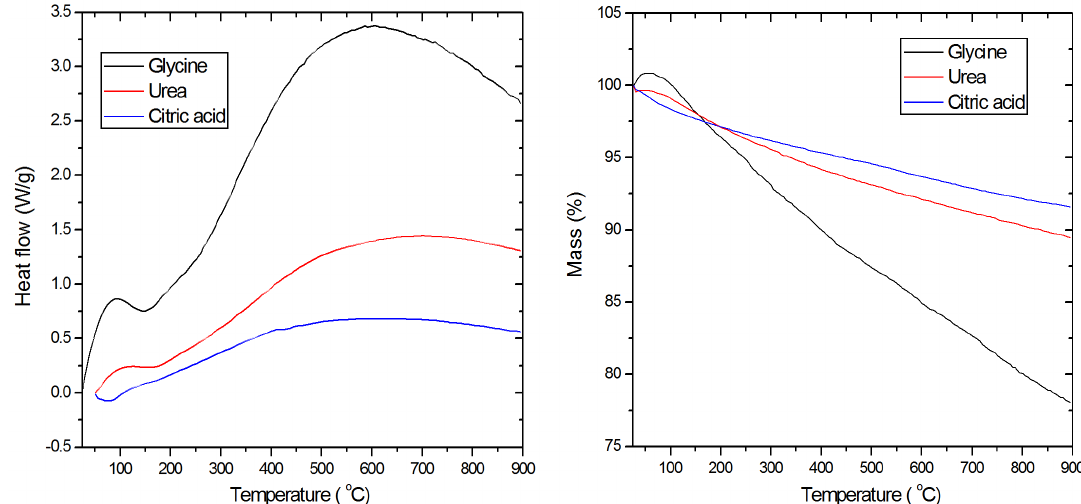
Figure 1. DSC and TG curves of ZnCr